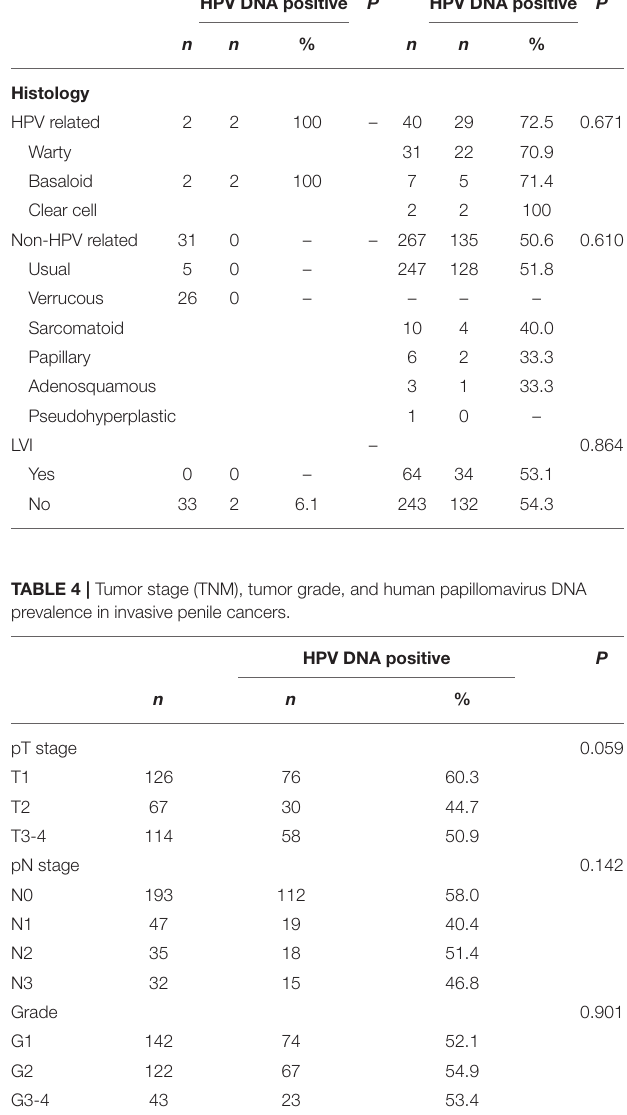
TABLE 3 | Histologic diagnosis and human papillomavirus DNA prevalence in penile cancers. Non-invasive penile cancers